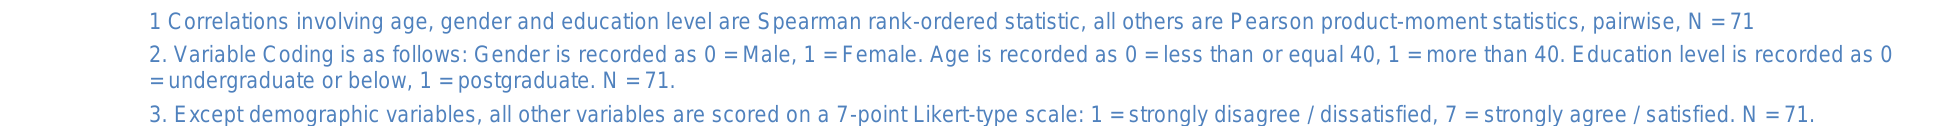
Table 1: Correlation1 Matrix between study